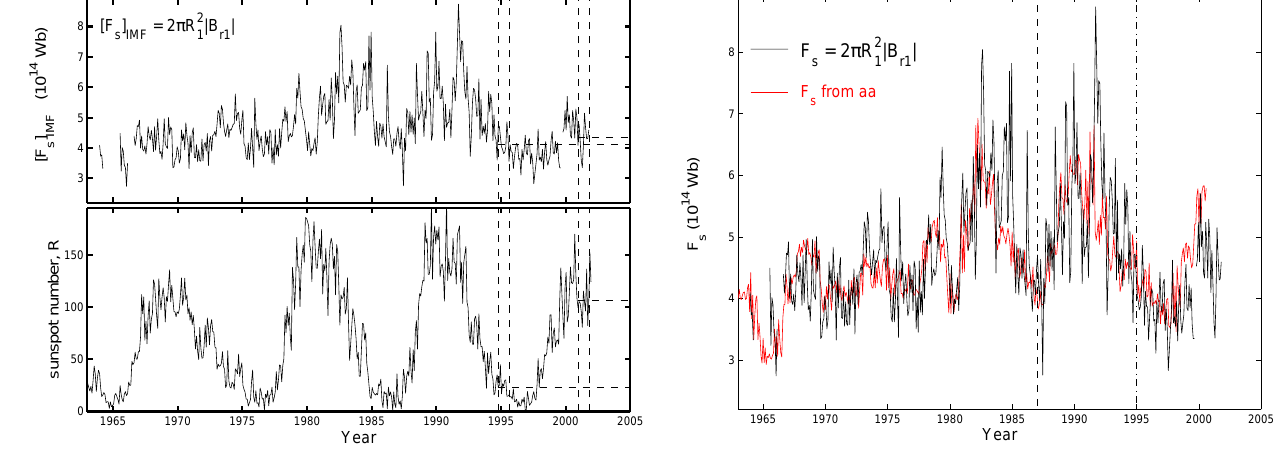
Fig. 1. The variation in monthly means of (top) the open solar flux deduced from IMF observations [ F s ] IMF = 2 πr 12 | B r 1 | (where r 1 = 1AU and B r 1 is the near-Earth radial component of the IMF) and (bottom) of the sunspot number R . The vertical dashed lines mark the fast latitude scans of the first and second perihelion passes of Ulysses. The horizontal dashed lines in each panel show the mean values during these passes.